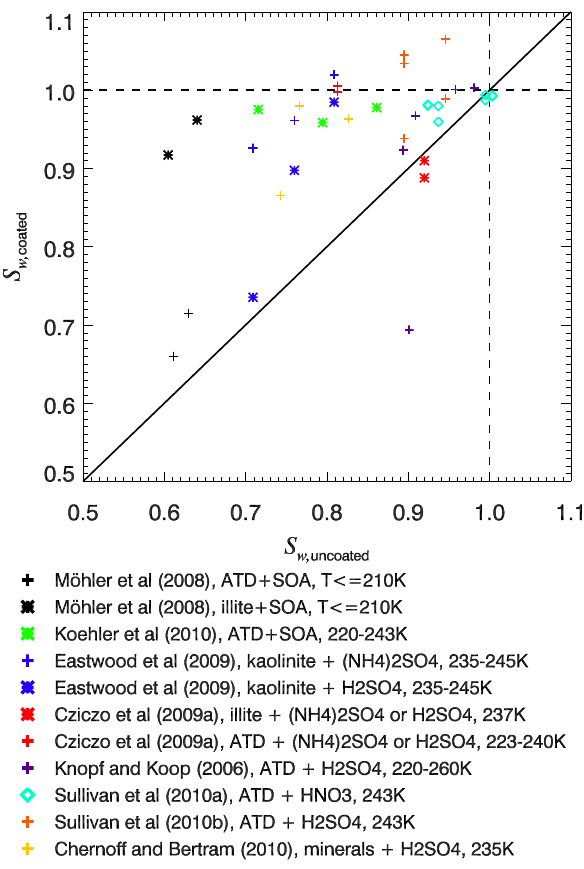
Fig. 9. Effect of different coatings on supersaturation with respect to water required to activate a specific fraction of IN in experiments at the temperatures given in the